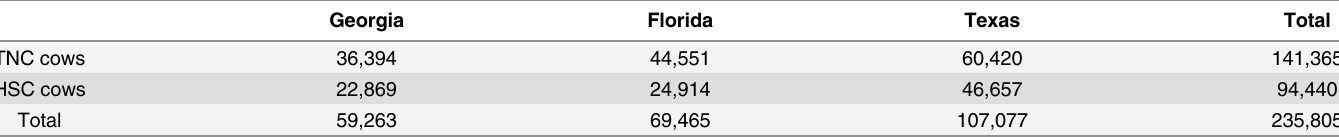
Table 2. Number of cows from Georgia, Florida and Texas that were included in the analyses of thermoneutral-conceived (TNC) and heat stress- conceived (HSC) Holstein